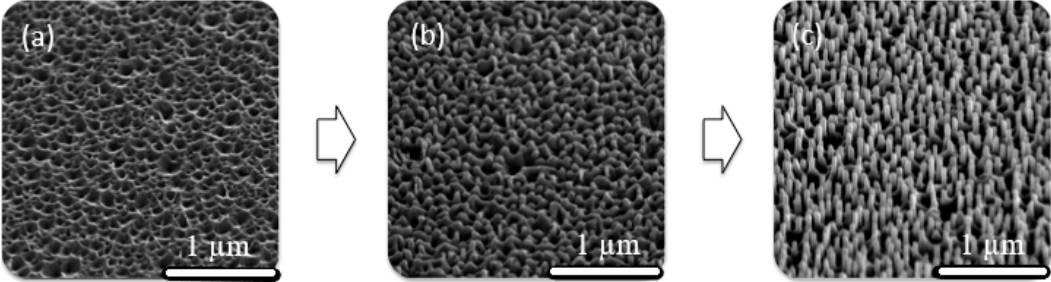
Figure 11. SEM images revealing the growth process of ZnO NWs on ZnO SL by PLD. Ablated ZnO species are adsorbed on the seed layer (SL) nanostructured surface ( a ). ZnO species migrate to the nucleation points that are energetically favorable sites for growth of ZnO NWs ( b ), followed by continuous growth ( c ).